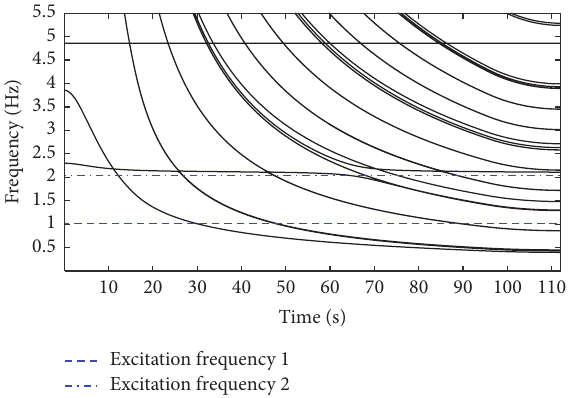
Figure 8: Longitudinal, torsional, and excitation frequencies.